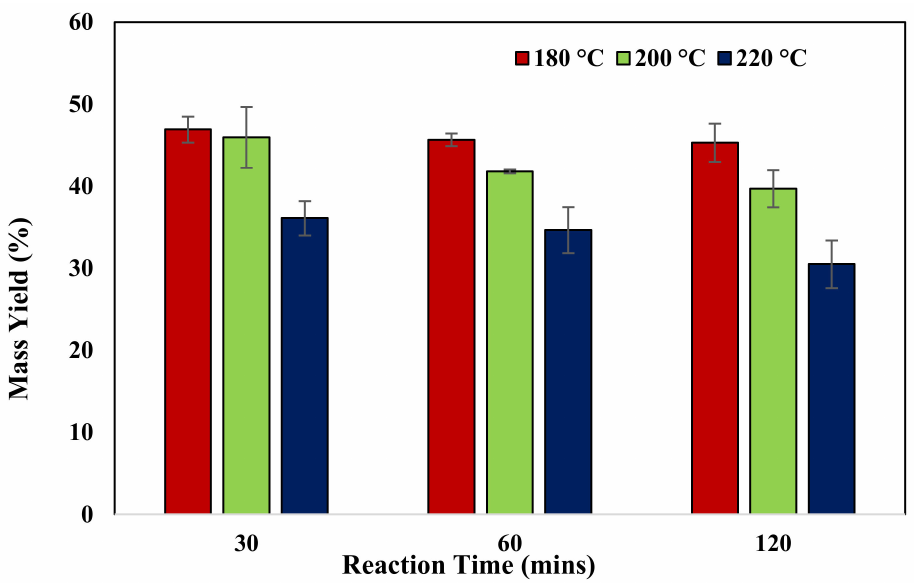
Figure 6. Effect of the reaction temperature on the mass yield of the hydrochar in HTC.